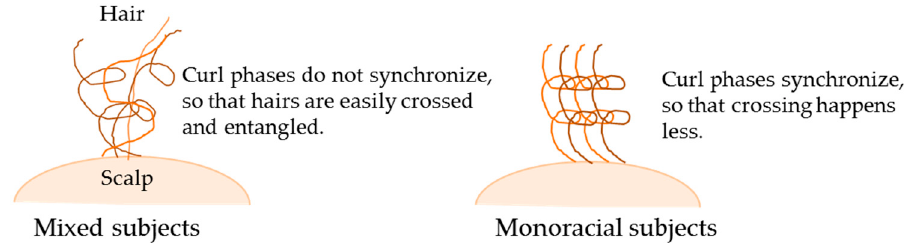
Figure 6. Image of the entanglement of hairs near the scalp.